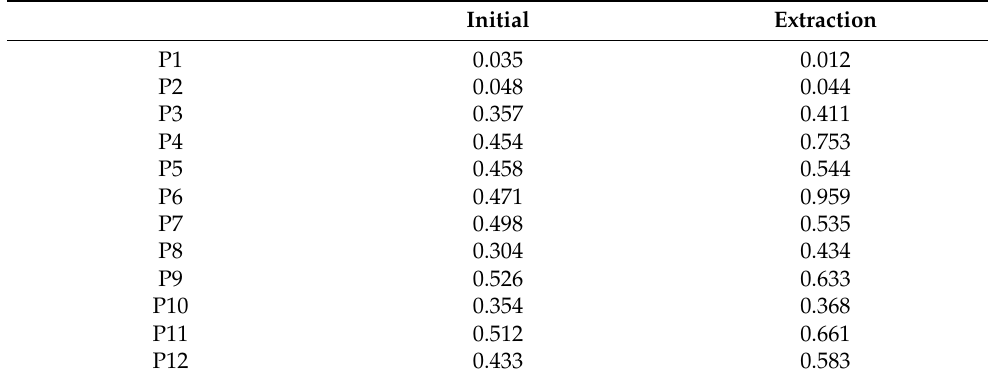
Table 11. Commonalities obtained using the extraction method of maximum likelihood. One or more commonality estimates greater than 1 were encountered during iterations; the resulting solution should be interpreted with